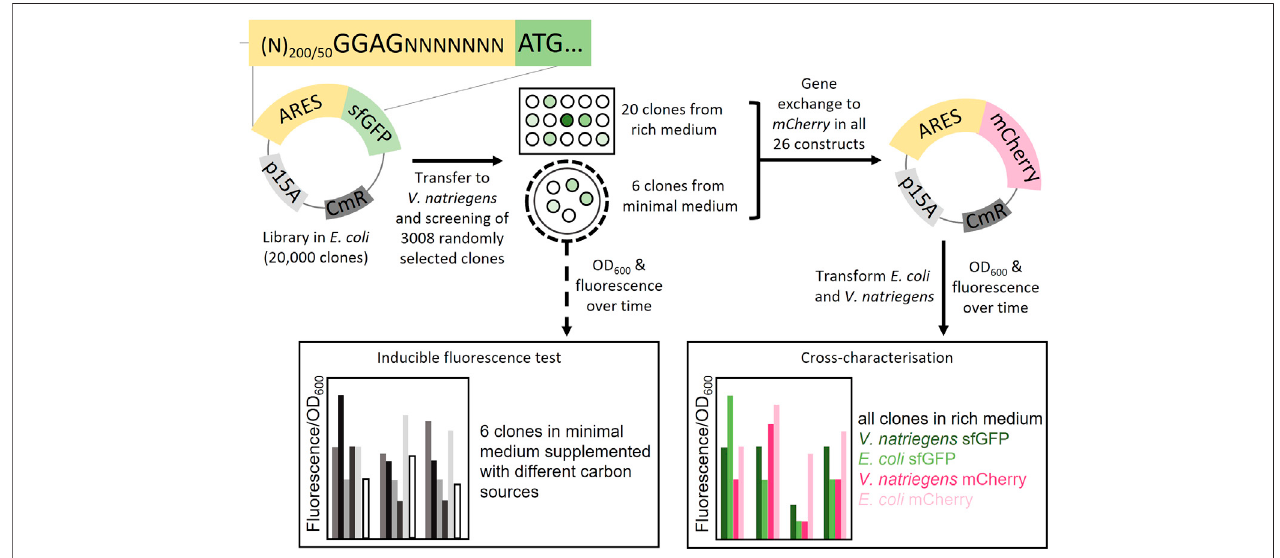
FIGURE1| Schematicoverviewofthestudy.Plasmidlibrarieswereconstructedbycloningarti fi cialregulatorysequences(ARES)consistingofrandomnucleotides upstream of the reporter gene sfGFP . In total three libraries were constructed, two libraries with ARES length (200 and 50 random nucleotides) with a fi xed Shine- Dalgarno (SD) sequence, GGAG; and a library with only 200 nt random DNA with no SD-sequence. The plasmid libraries were screened in V. natriegens in two different ways: One, 3008 V. natriegens library clones were randomly selected from rich medium plates and cultivated in rich medium in 96-well format. The 3008 clones werescreened for sfGFP fl uorescence using a fl uorescence platereader. 20cloneswere selected from the rich medium screening. Two, the V.natriegens libraries were plated out on minimal media plates. From these plates, six fl uorescent colonies were visually detected and selected. The six clones from the minimal medium screening were used to conduct a inducible fl uorescence test in minimal media supplemented with different carbon sources. Plasmids from all 26 constructs were extracted and sfGFP was exchanged with mCherry . Transformations were performed so that both V. natriegens and E. coli would carry all 26 constructs with each of the sets of reporter proteins (104 different clones). The clones were cross-characterised in both E. coli and V. natriegens , using fl uorescence/OD 600 as the